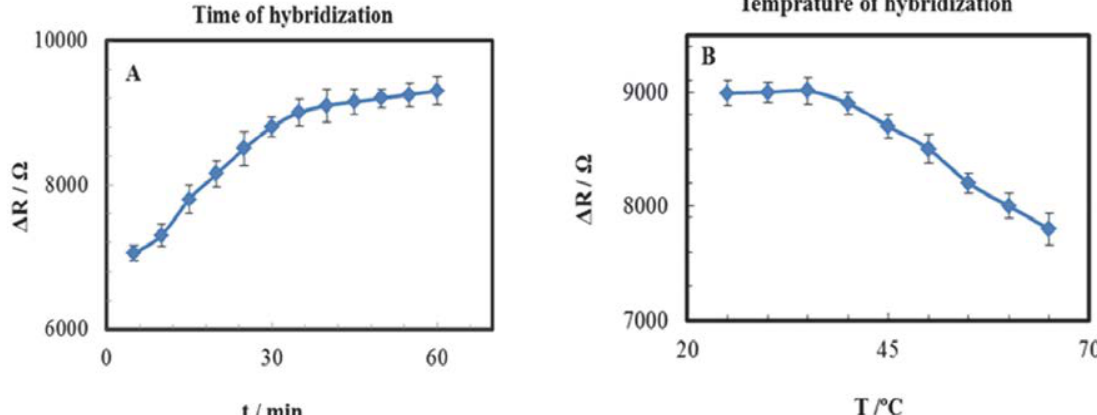
Figure 6. Optimization of operating conditions in a solution containing [Fe(CN) 6 ] 3–/4– (0.5 mmol L –1 ) and KCl (0.1 mol L –1 ) and the number of independent experiments is 3 (n=3): (A) the influence of target DNA (1×10 –12 mol L –1 ) interaction time and (B) the effect of hybridization temper-